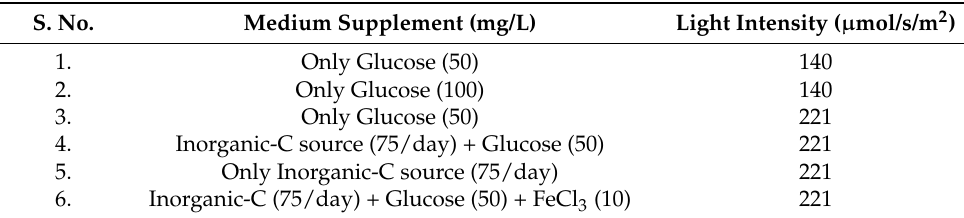
Table 1. Different parameters used in Phase 1. (24 h:0 h light–dark cycle, nitrate: N = 75 mg/L, phosphate: P = 15 mg/L, 140 rpm, initial biomass concentration: 400 mg/L, temperature: 25 ◦ C, Light source: fluorescent tube lights).